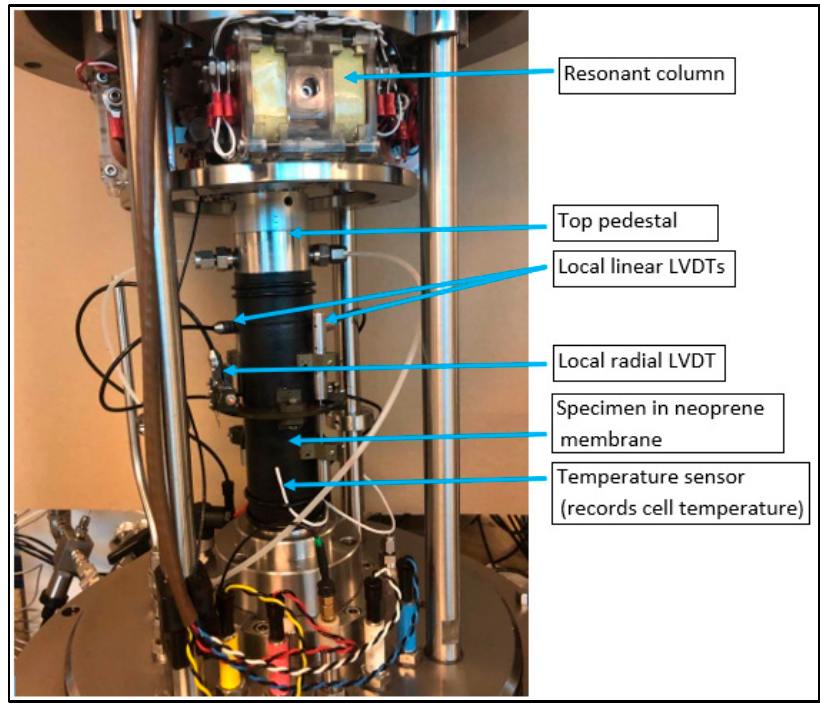
Figure 2. Image of formed sand specimen set-up on the ETAS base with the local instrumentation for measuring specimen displacement (LVDTs) attached along with external temperature sensor. Table 1. Basic soil